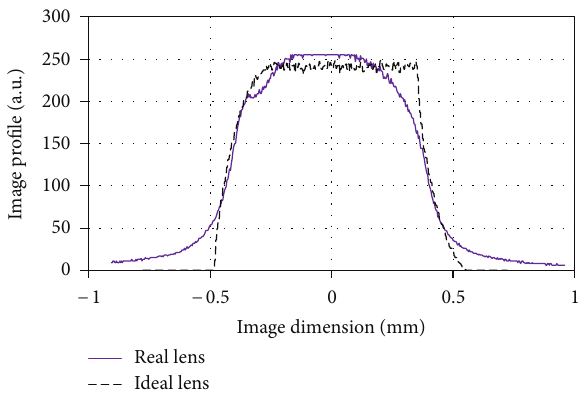
Figure 7: Profiles of simulated and detected images.